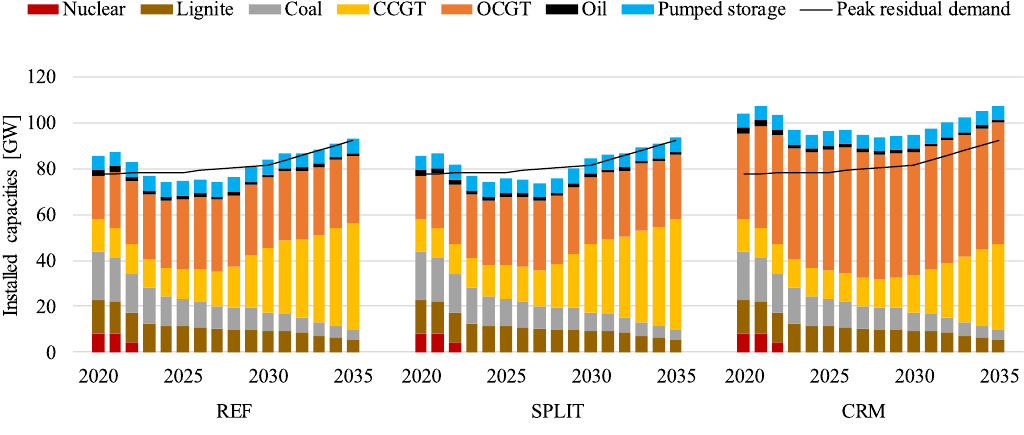
Figure 6. Simulated development of the conventional power plant capacities in Germany for all three cases REF, SPLIT and CRM. Abbreviations: CCGT—combined cycle gas turbine, OCGT—open cycle gas